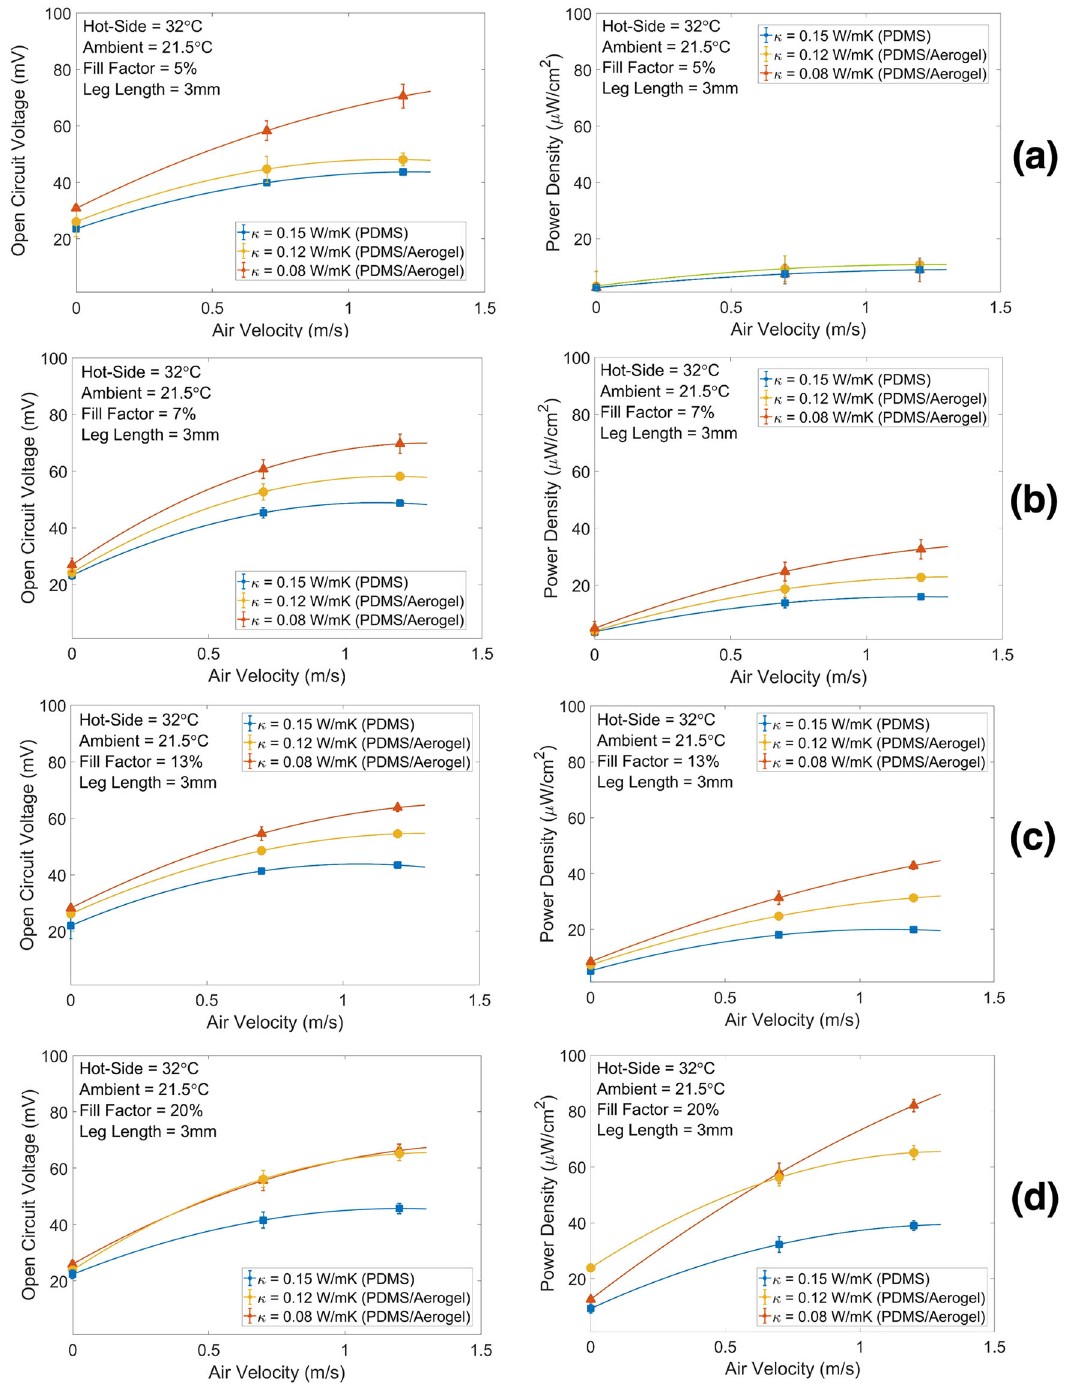
Fig. 6 Open-circuit voltage and power density of fl exible TEGs versus air velocity. Different panels refer to different module fi ll factors of a 5%, b 7%, c 13%, and d 20%. Error bars indicate standard